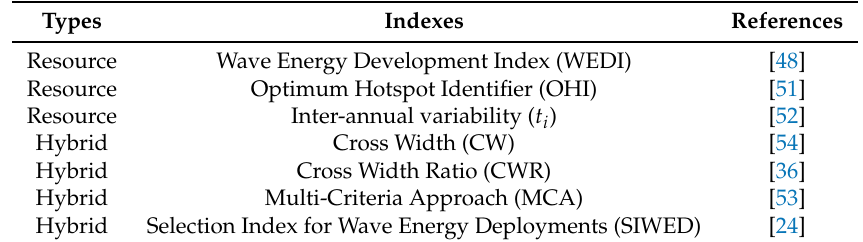
Table 3. List of specific indices for wave energy applications, hybrid implies a combination of resource and power production